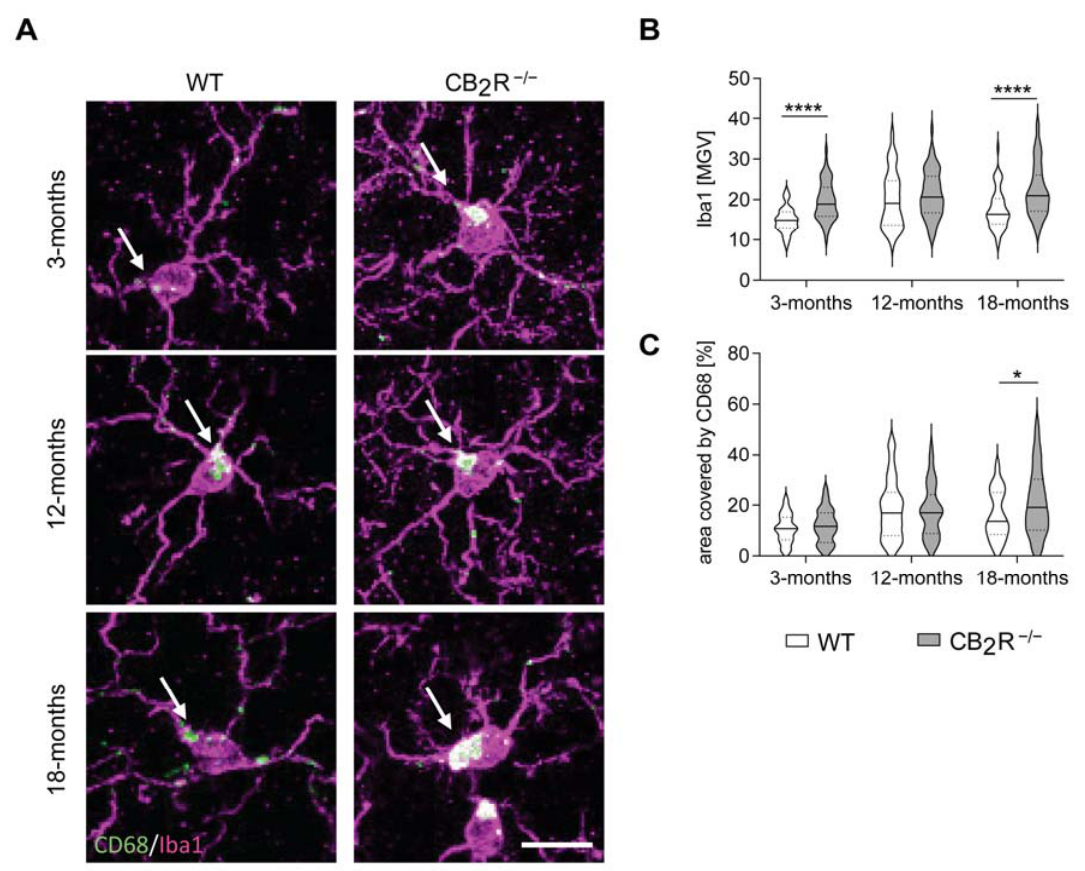
Figure 5. Iba1 and CD68 intensity is enhanced in CB 2 R − / − microglia. Representative microscopy images from pyramidal microglia of 3-, 12- and 18- month old WT and CB 2 R − / − mice with a scale bar of 10 µ m ( A ). Iba1 intensity increased with age in both genotypes and was also enhanced in CB 2 R − / − microglia when compared to WT microglia ( B ). CD68 expression was measured by area covered and increased significantly with age ( C ). Data displayed as median (full line) with 25 and 75 percentiles (dotted lines) ( B , C ). WT mice—white; CB 2 R − / − mice—grey. N = 6 mice/genotype/age group. Two-way ANOVA followed by Sidak’s multiple comparisons with * p < 0.05, **** p < 0.0001 significance between genotypes within the same age